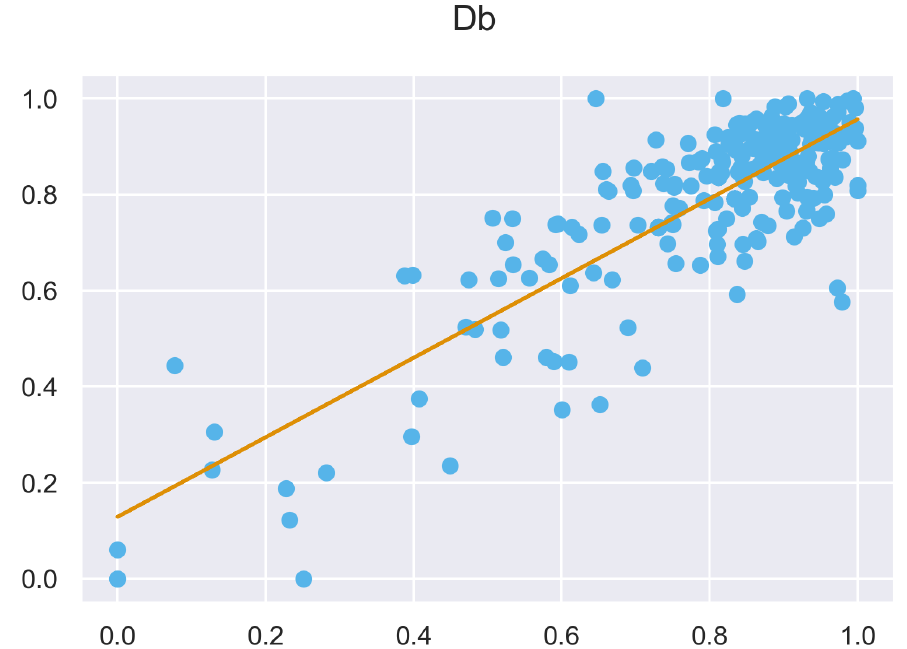
Figure A45. ULS and TLS D b regression at 5m grid size.